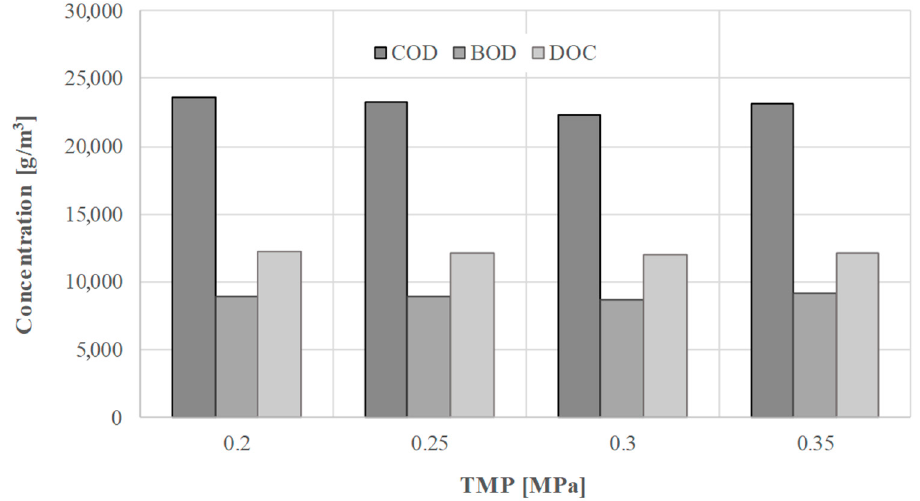
Figure 5. The influence of transmembrane pressure on the concentration of organic substances in permeates of the liquid fraction of digestate, using 10 kDa ultrafiltration membrane (trans-membrane pressure (TMP); chemical oxygen demand (COD); biological oxygen demand (BOD); and dissolved organic carbon (DOC)).